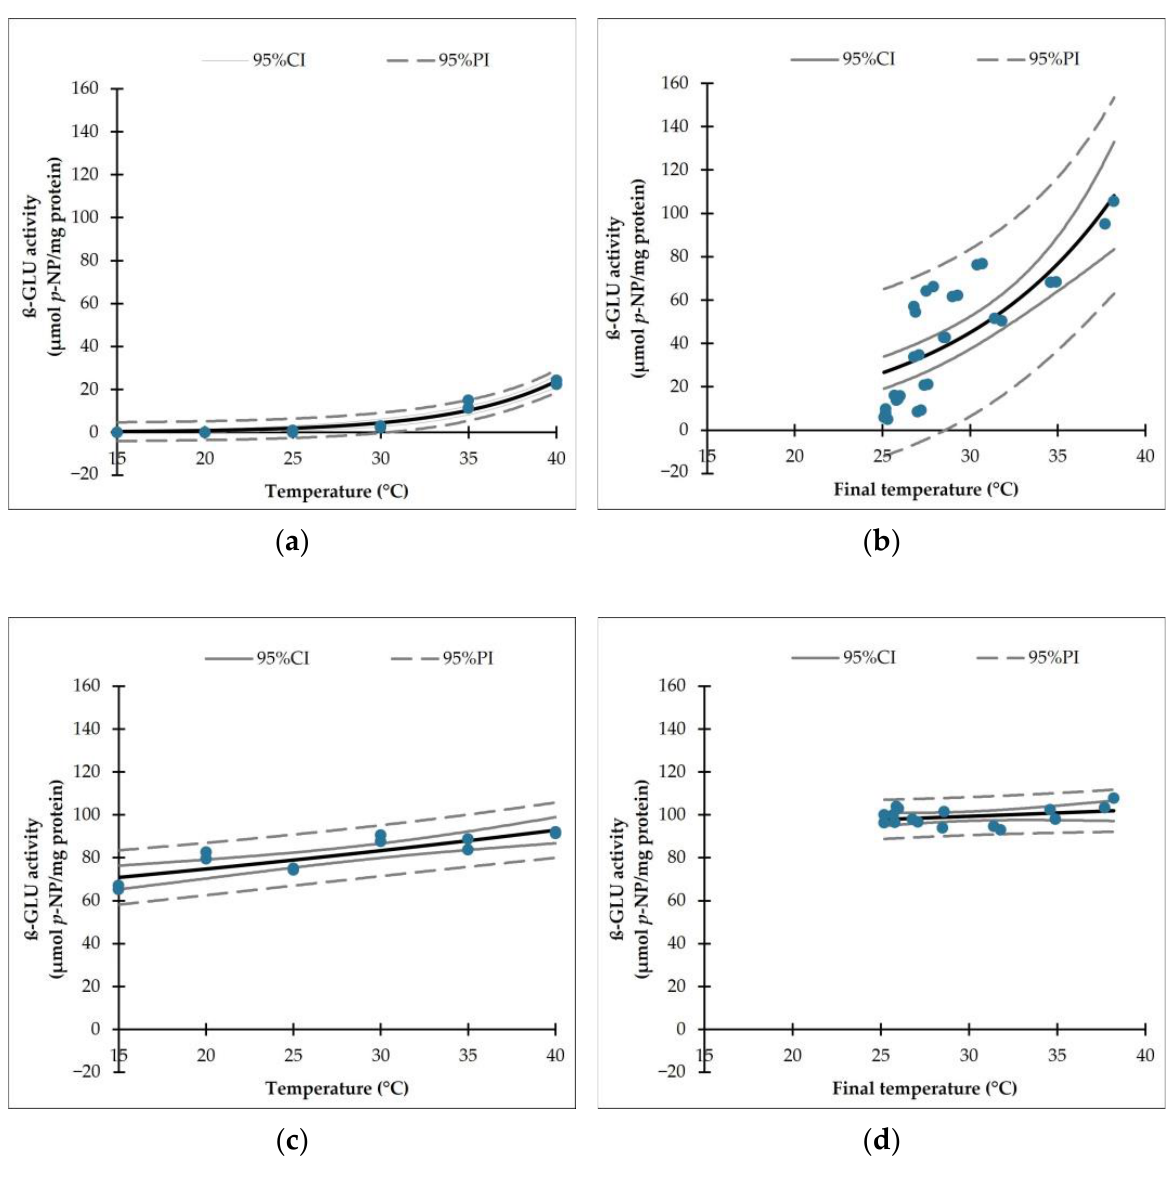
Figure 2. Nonlinear exponential curve function for β-glucosidase (β-GLU) activity as a function of temperature for: ( a ) thermal treatment (TT); ( b ) ultrasonic treatment (US); ( c ) TT and incubation for 30 min at 25 °C; ( d ) US and incubation for 30 min at 25 °C. The black line represents the model curve, the gray solid line (95% CI) represents the 95% confidence interval, and the gray dashed line (95% PI) represents the 95% prediction interval. The circles represent plot-level data points. Table 3. Parameter estimates of the exponential curve for β-glucosidase (β-GLU) activity as a func- tion of temperature.